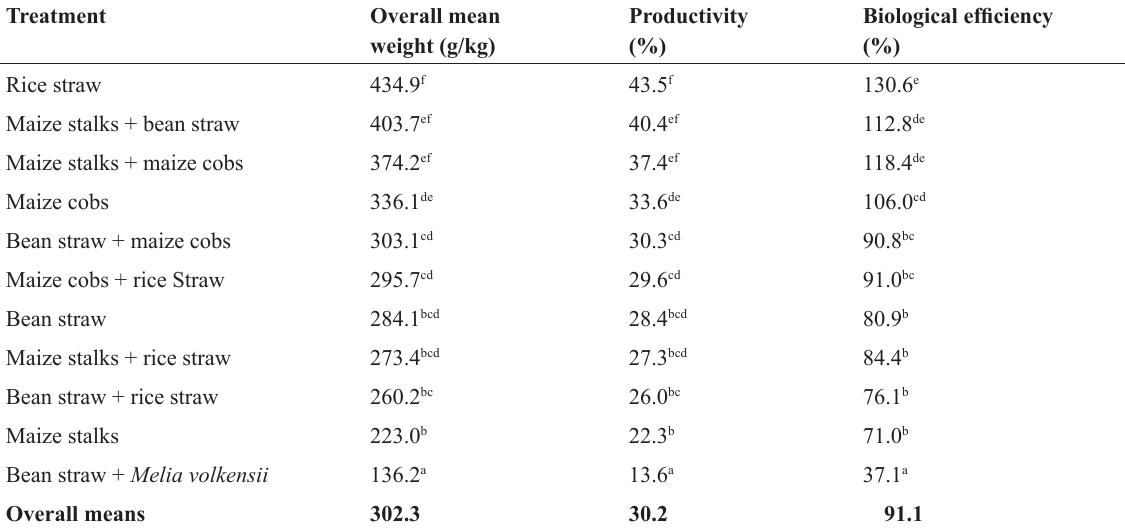
Table 4 Mushroom fresh weight (Ranked - largest), biological efficiency (BE) and productivity in function of substrate composition Treatment Overall mean